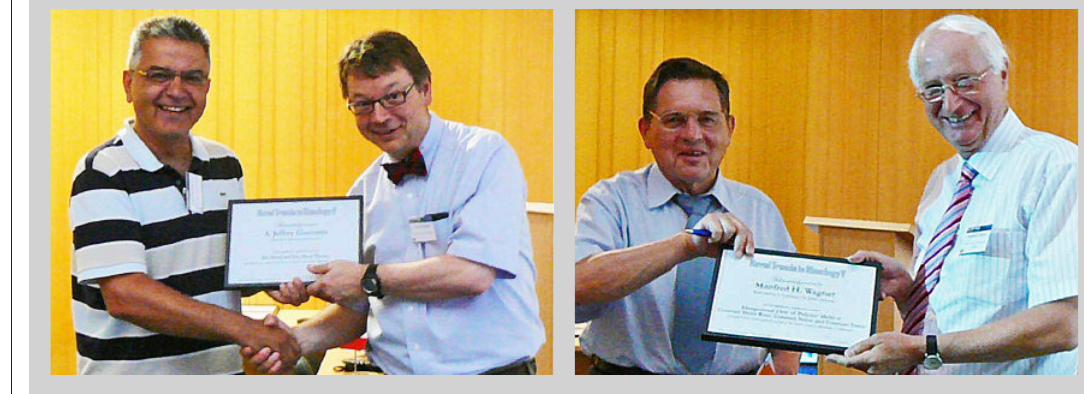
Figure 1 (above): Conference book. Figure 2 (left below): Prof. Jeffrey Giacomin (right) receiving the plaque from chairmen Prof. Savvas Hatzikiriakos (left) for his plenary lecture entitled as ‘Die Drool and Die Drool Theory’. Figure 3 (right below): Prof. Manfred Wagner (right) receiving the plaque from chairmen Prof. Helmut Münstedt (left) for his ple- nary lecture entitled as ‘Elongational Flow of Poly- mer Melts at Constant Strain Rate, Constant Stress and Constant